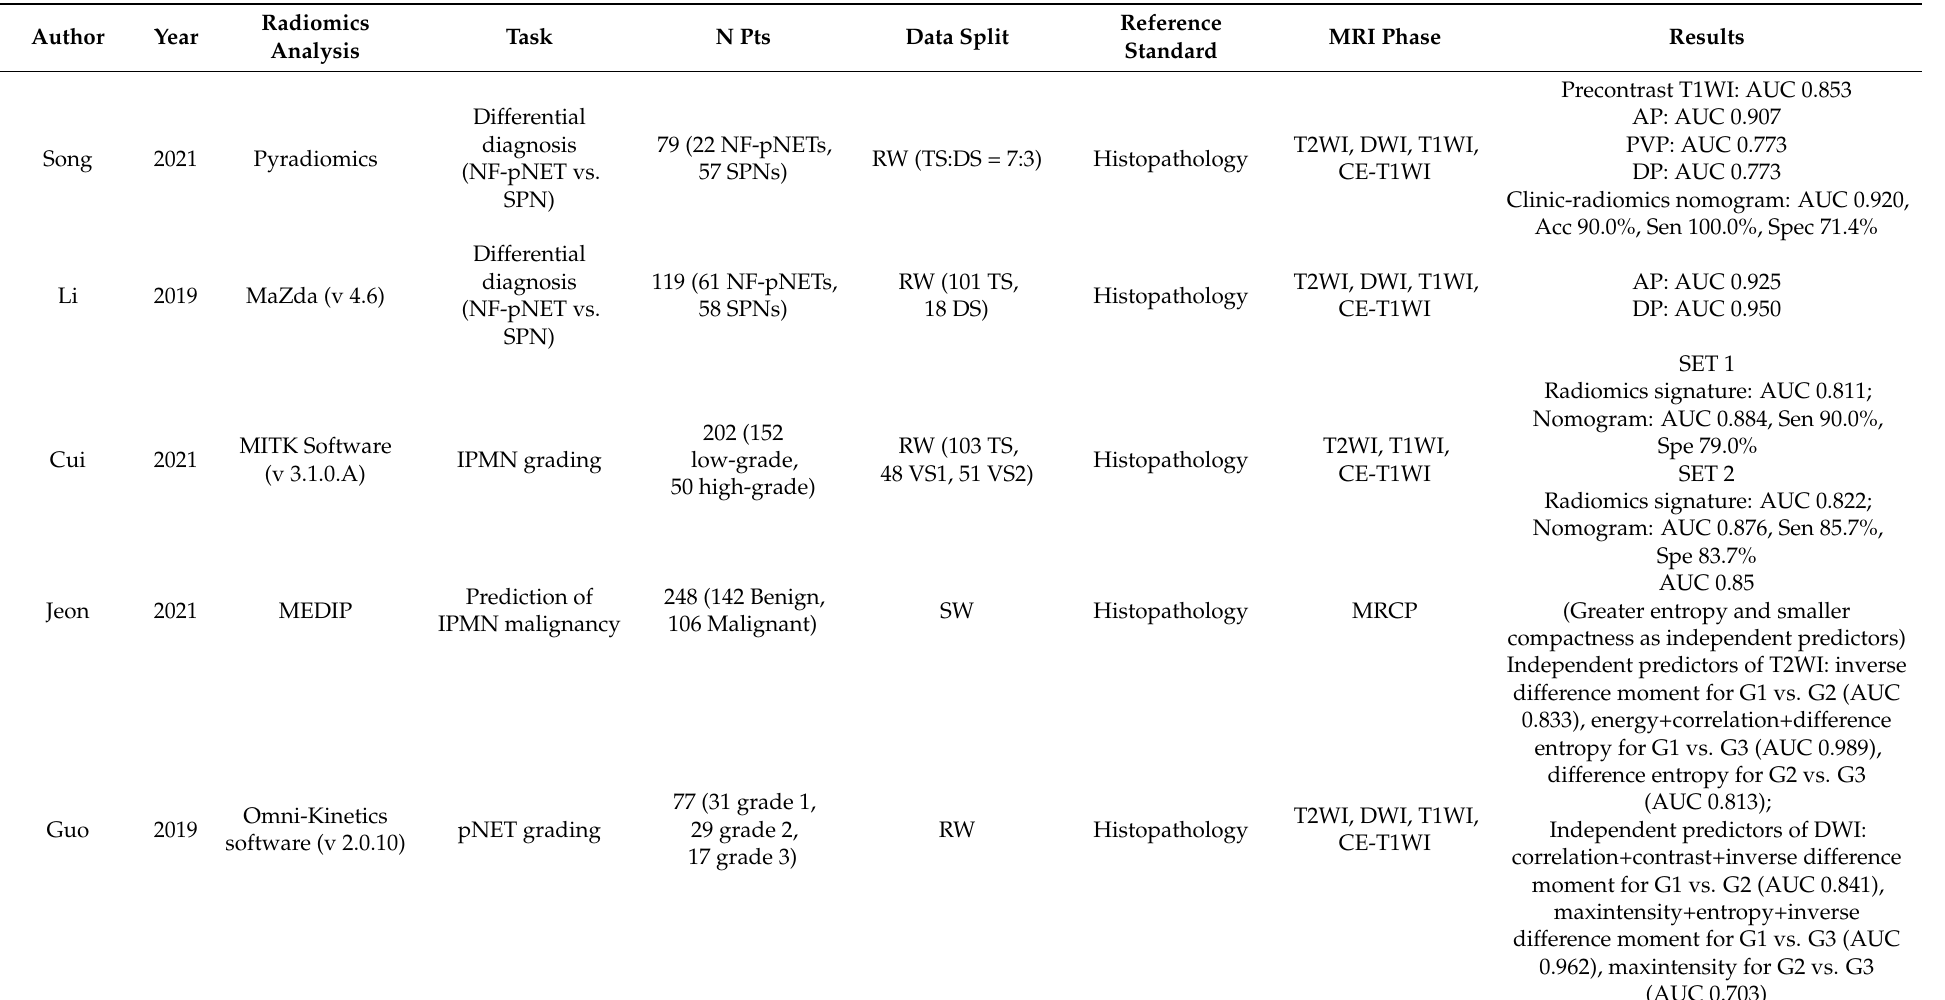
Table 3. Applications of radiomics in pancreatic MRI